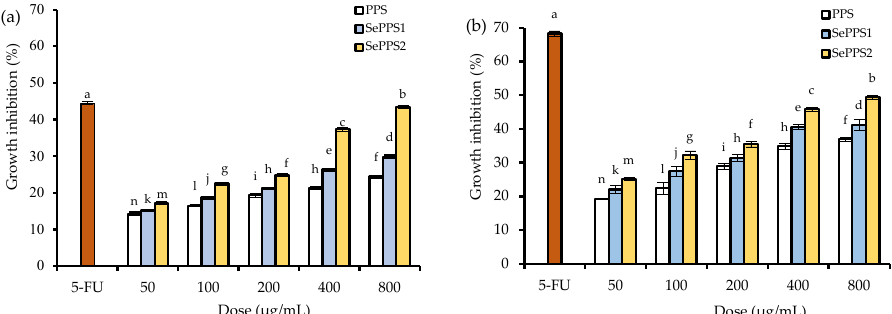
Figure 2. Proliferation inhibition (%) of positive control 5-Fu, P. oleracea polysaccharides (PPS), and two selenylated PPS products (SePPS1 and SePPS2) at the five dose levels on HCT-116 cells at 24 ( a ) and 48 h ( b ). Different lowercase letters above the column indicated significant differences of the mean values ( p < 0.05).